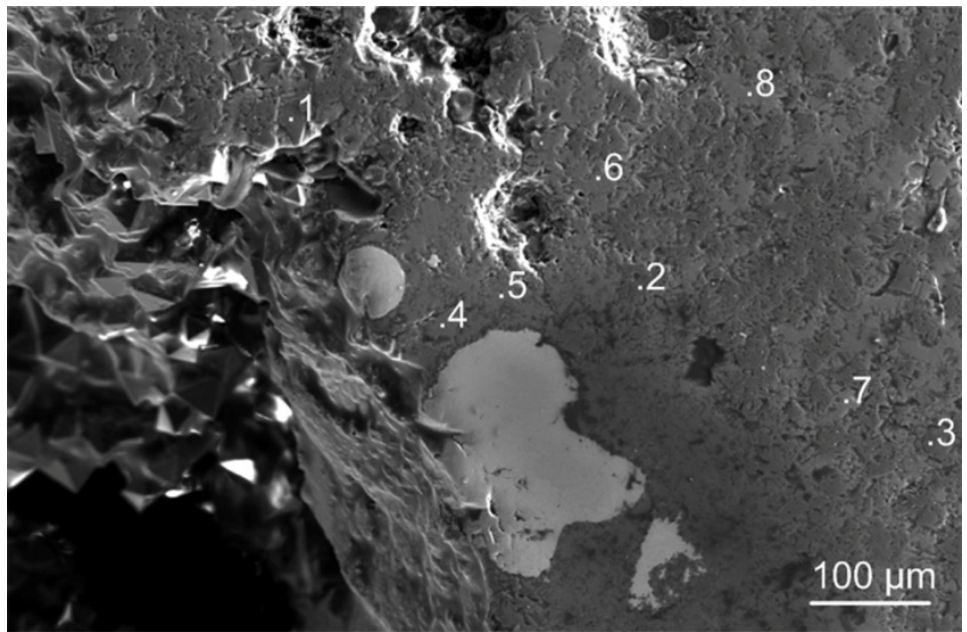
Figure 3. BSE image of slag area at the slag–weld metal interface: MP1 slag sample. (See Table 5 for the analyses of the numbered phases in Figure 3). Table 5. SEM analyses of marked phase positions in Figure 3 (mass%).